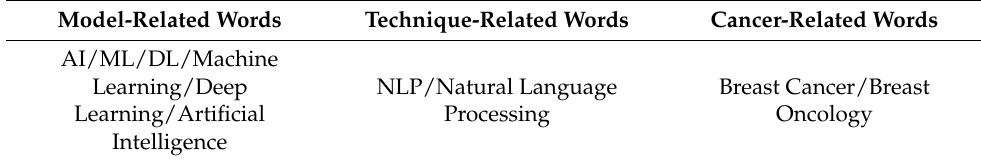
Table 1. Keywords for research related to ML-based NLP in breast cancer